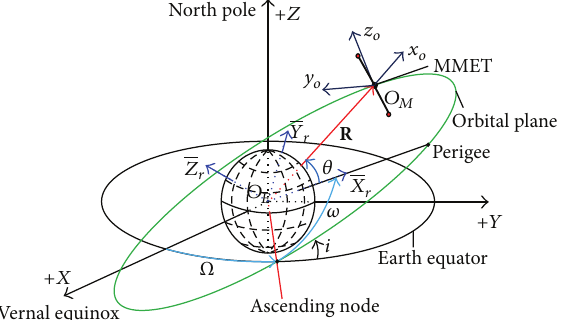
Figure 4: Geometry of MMET’s 3D rigid